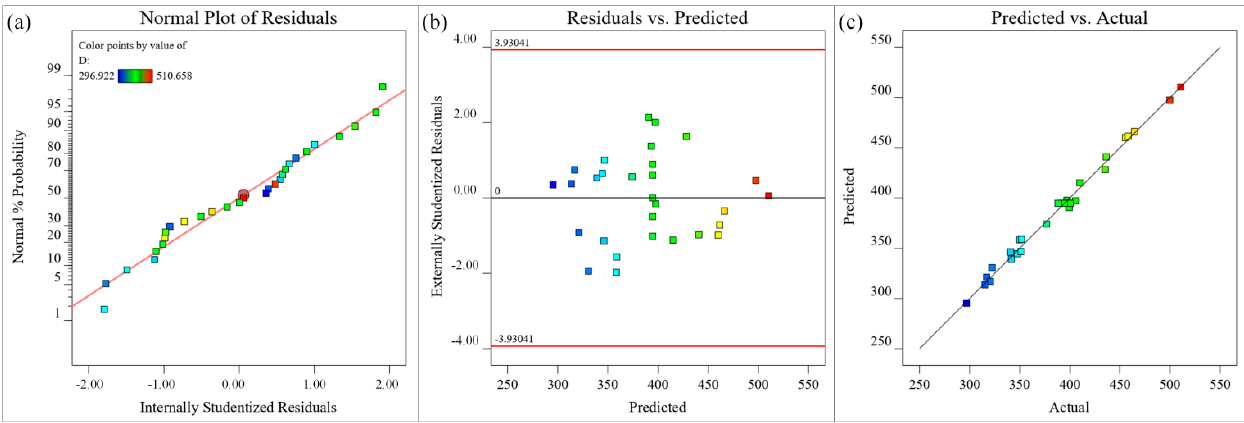
Figure 11. Diagnostic plots for depth (µm) ( a ) Normal plot of residuals, ( b ) Residuals versus predicted plot, ( c ) Predicted versus actual values plot.